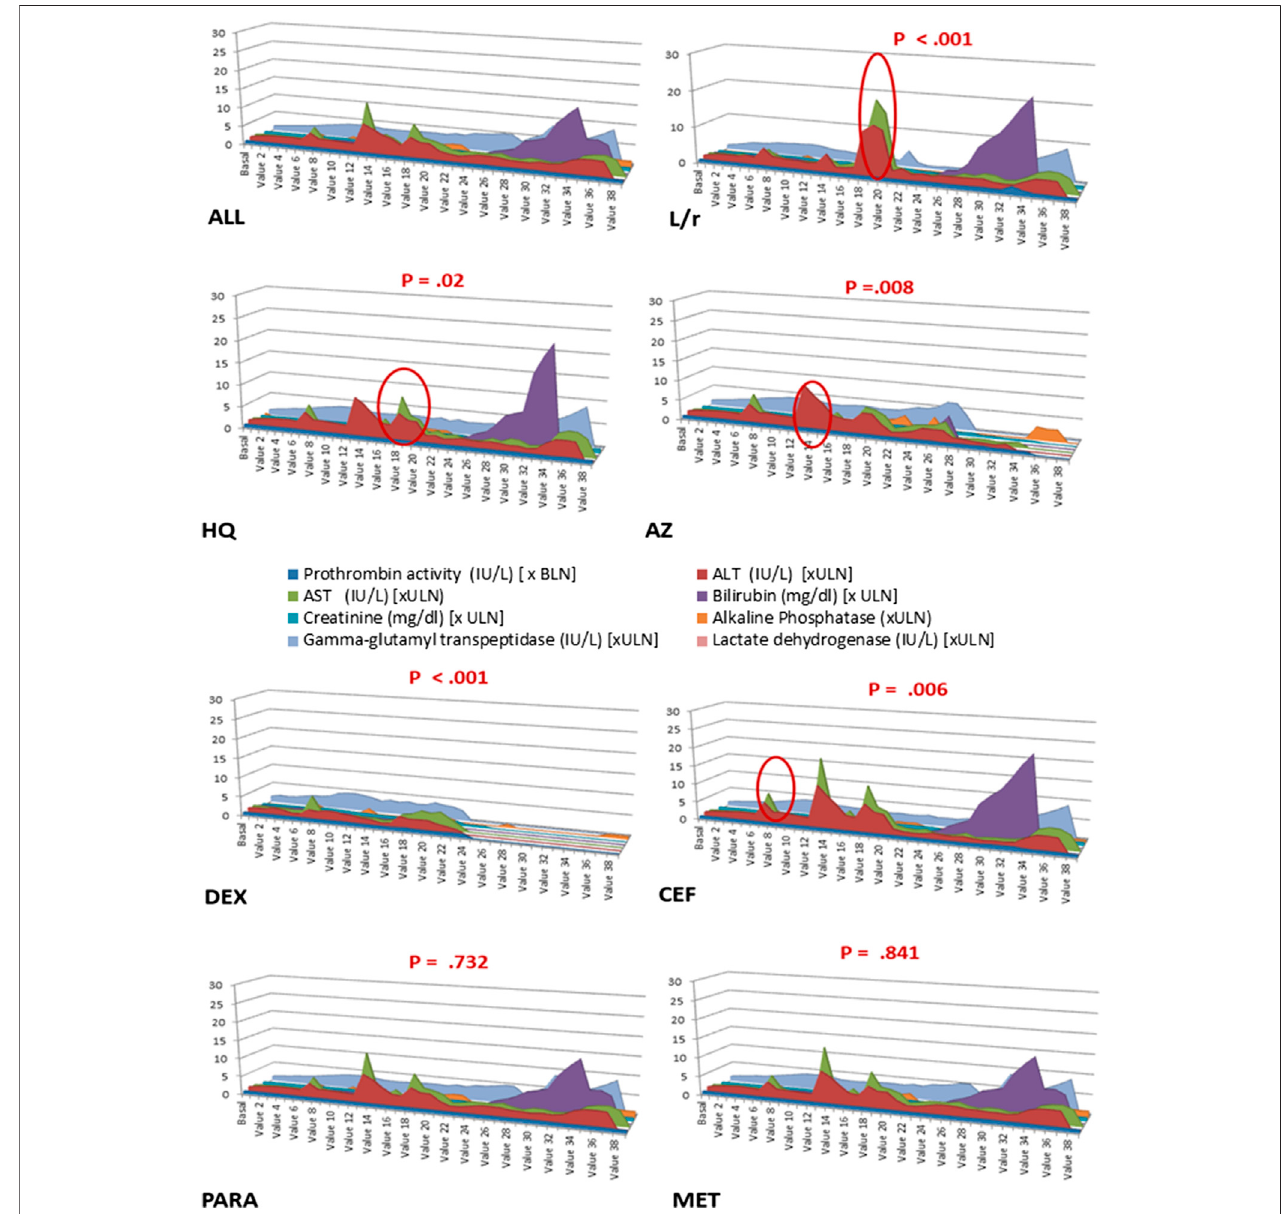
FIGURE3| Sequencechart:ProgressionofparametersrelatedtoliverfunctioninCOVID-19patientsduringhospitalizationaccordingtothetreatmentundergone. The X -axis indicates the value number (baseline, thelast value before drug administration; value 1, fi rst value after administration; values 2 – 19, values on days 1 – 20after the fi rst dose administration; values 20 – 39, results between days 21 and 60 of hospitalization). The Y -axis indicates the number of times above or below the limit of normality, as appropriate. The red circle indicates the points with statistical signi fi cance. ALL, all patients; AZ, azithromycin; BLN, below limit of normal; CEF, ceftriaxone; HQ, hydroxychloroquine; DEX, dexamethasone, L/r, lopinavir/ritonavir; MET, metamizole; PARA, paracetamol; ULN, upper limit of normality.